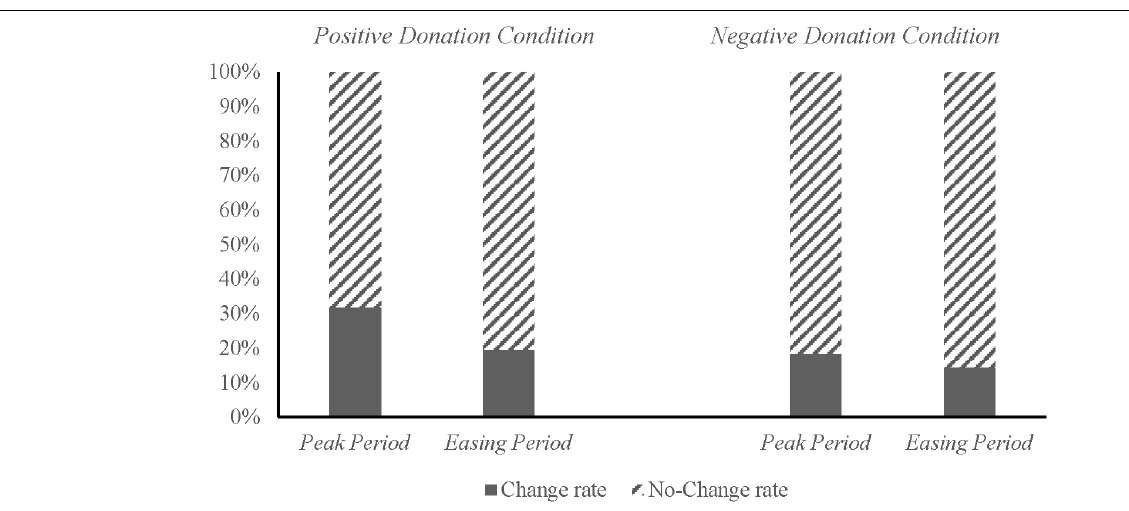
FIGURE 3 | Change rates of the decisions of the participants in the Peak and Easing Periods. TABLE 5 | Changes in the contagion of donation behaviors along with the abatement of the COVID-19 pandemic.